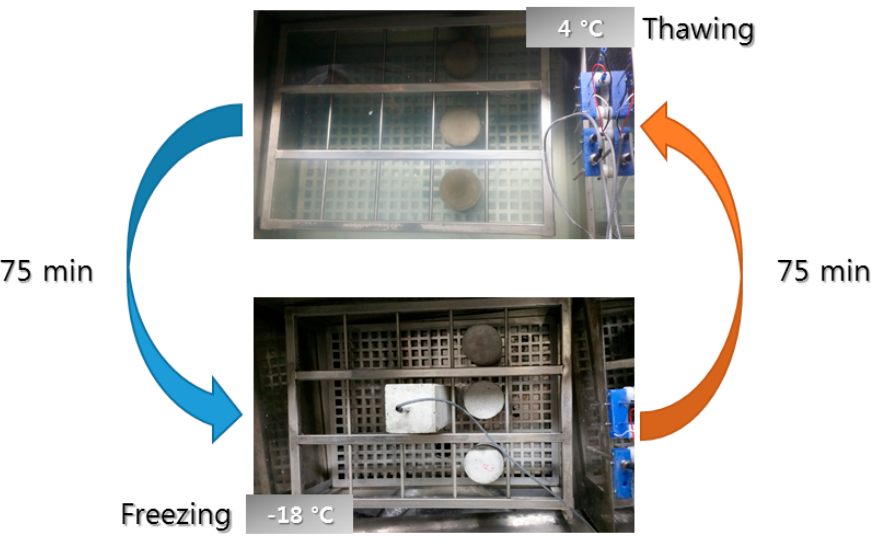
Figure 2. Cycles of freezing and thawing damage of concrete.